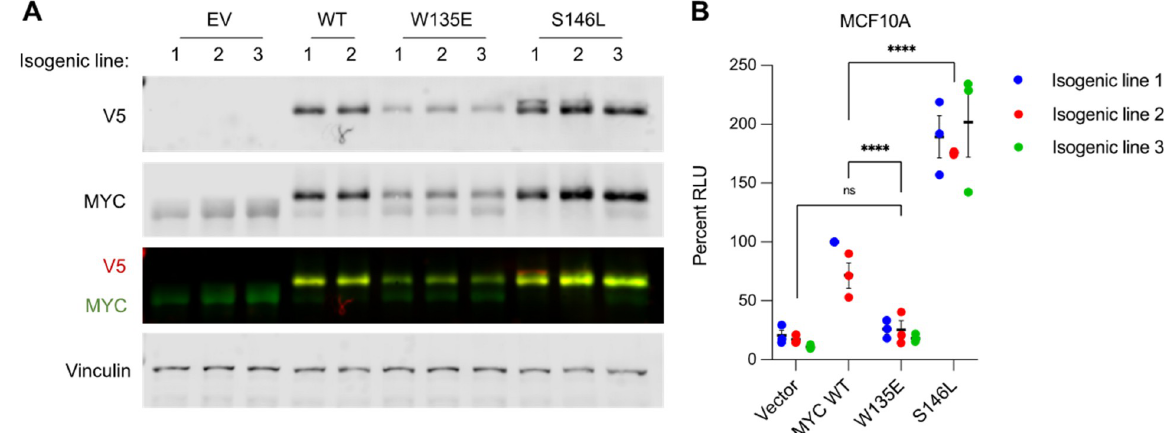
Fig 5. MYC S146L enhances cell survival in non-adherent conditions. (A) Western blot of V5-tagged MYC expressing MCF10A isogenic (clonally derived) cell lines. (B) Growth in low attachment assay of MCF10A cell lines represented in (A). Data represent results of three independent experiments normalized to MYC WT isogenic line 1. Percent RLU = relative luminescence units (arbitrary). Error bars represent ± SEM. Statistics: 2-way ANOVA with Tukey’s multiple comparisons test, ns = not significant, ���� p < 0.0001.